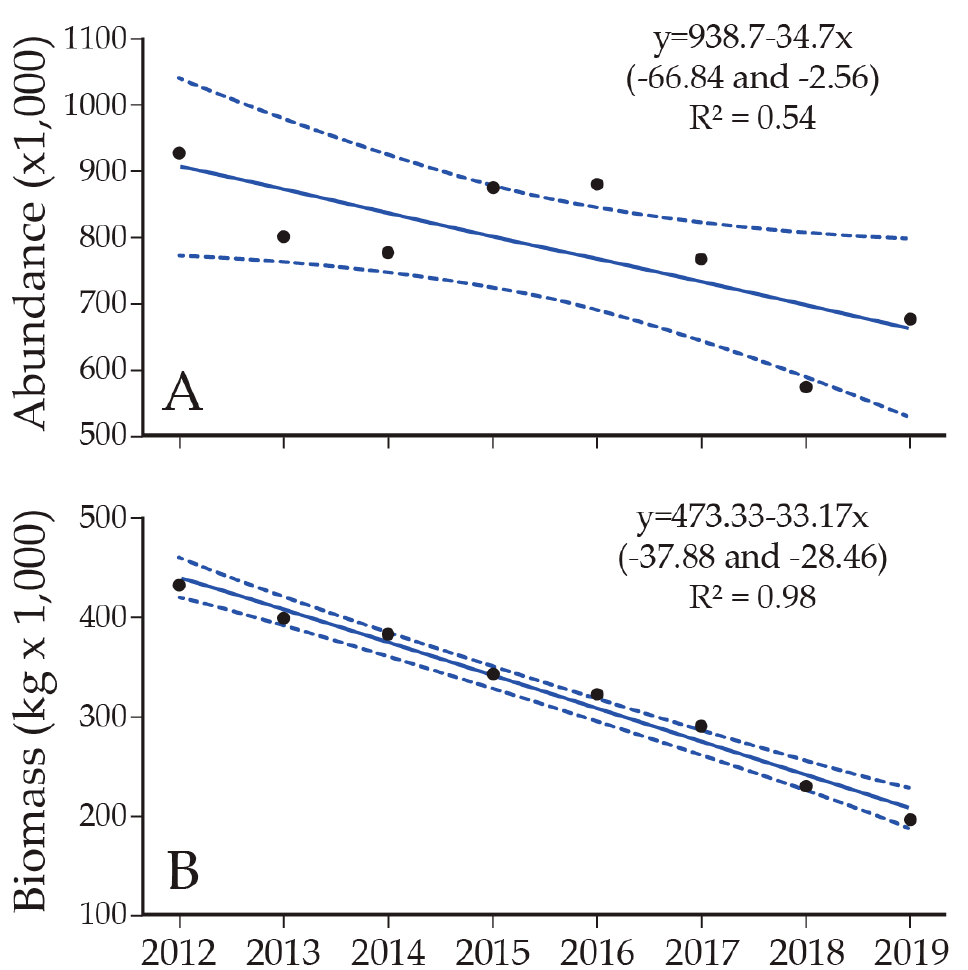
Figure 9. Total ( A ) abundance and ( B ) biomass of age-2 and older lake trout at the start of the year from 2012 through 2019 estimated using a statistical catch-at-age (SCAA) model [81]. Blue lines represent simple linear regression models with 95% confidence intervals (dashed lines). Numbers within parentheses are the upper and lower 95% confidence limits of the slope parameter estimate, indicating temporal declines in these response variables because intervals do not include zero.